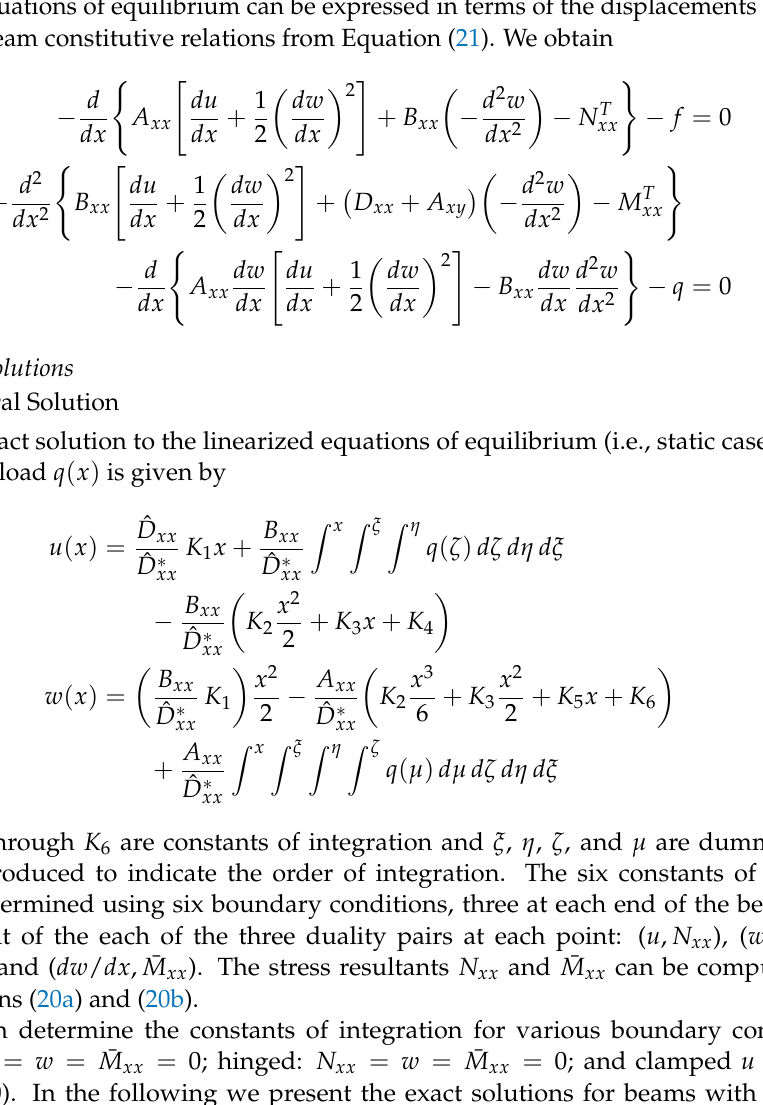
Figure 1. Variation of the normalized ( a ) axial stiffness coefficients ¯ A xx ( n ) = A xx / E 2 A 0 and ¯ D xx ( n ) = D xx / E 2 I 0 and ( b ) coupling stiffness coefficients the power-law index, n , for various values of the modulus ratio, M = E 1 / E 2